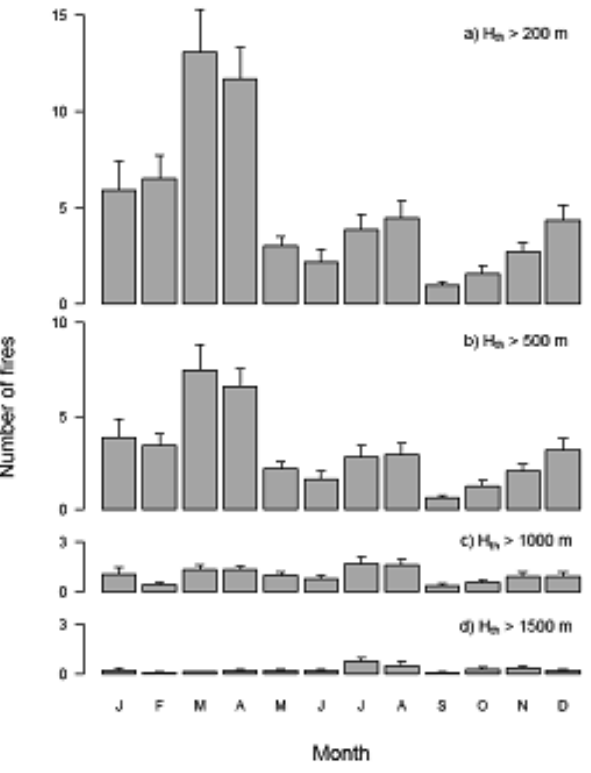
Fig. 3. Monthly fire distributions 1969–2008 according to the different elevation thresholds. The bars correspond to the standard